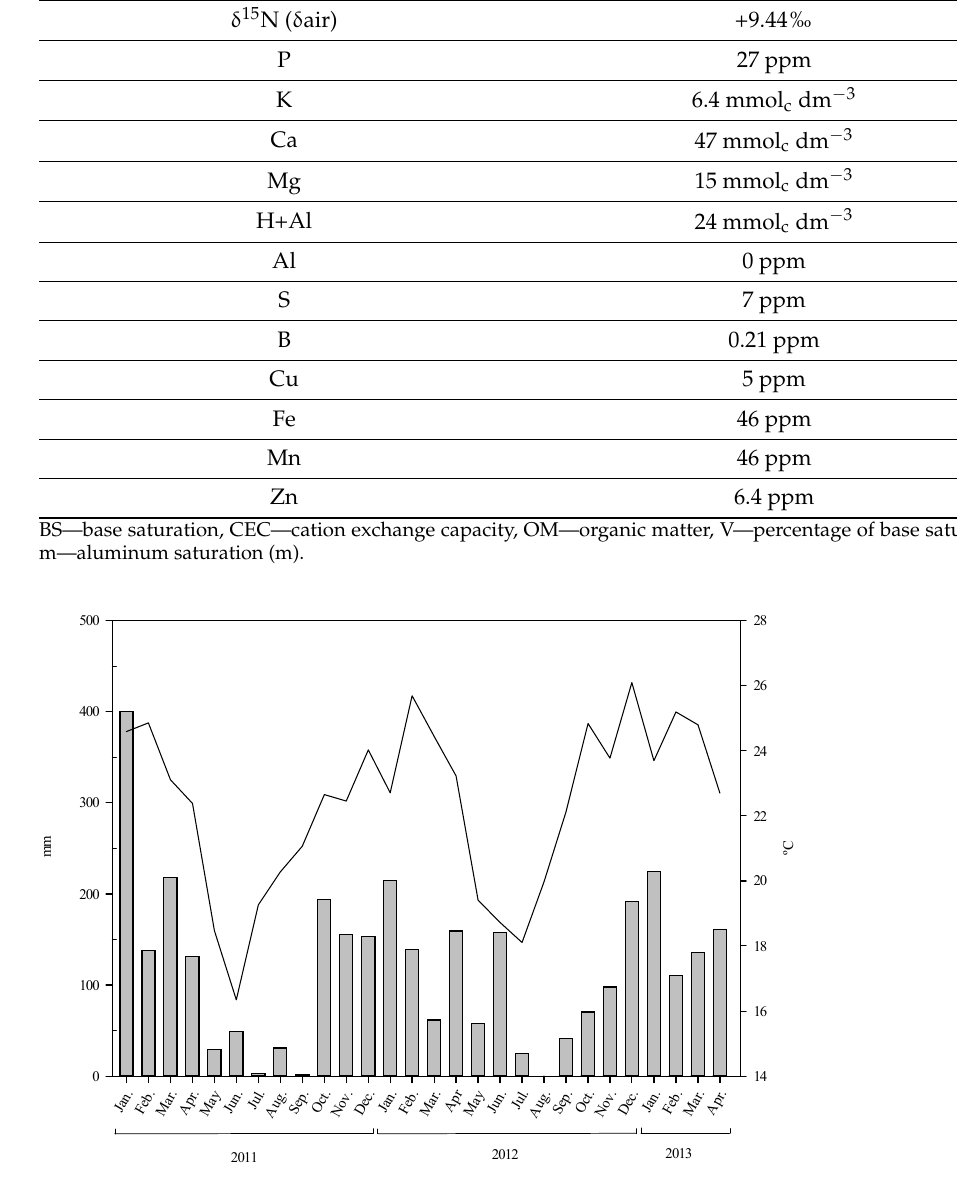
Table 2. Physical and chemical characteristics in depths between 0 and 20 cm.